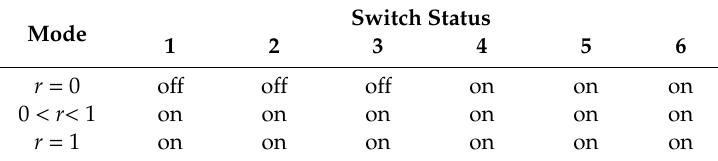
Table 2. Switch status of each operation